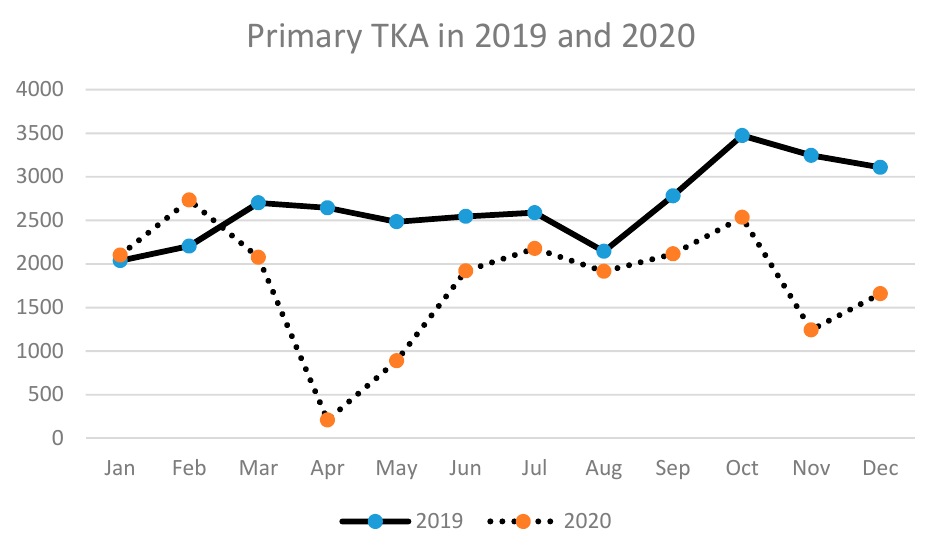
Figure 6. Number of primary total knee arthroplasties (TKA) performed in the particular months of 2019 and 2020 in Poland.